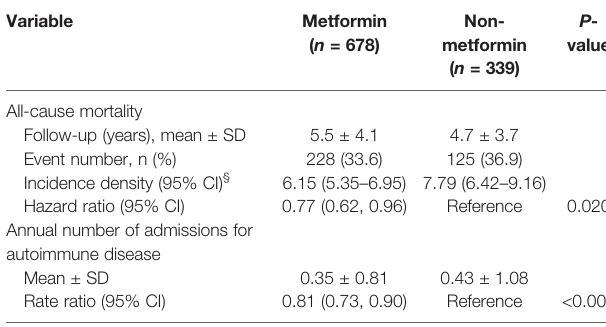
TABLE 2 | Event numbers and incidence density of the primary outcomes between the study cohorts.